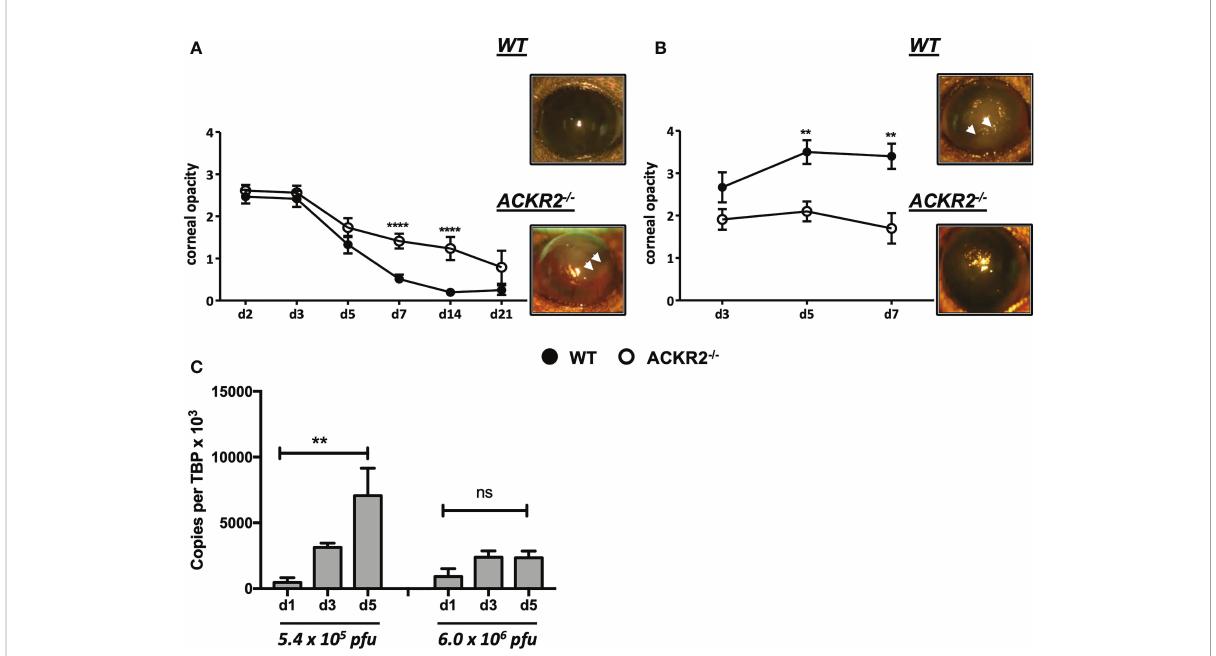
FIGURE 1 Deletion of ACKR2 exacerbates moderately severe HSK but has no effect on severe/maximal HSK. (A, B) Corneas of 6-8 weeks old sex-matched WT ( fi lled circle) and ACKR2 -/- (clear circle) mice were infected with HSV-1 virus after corneal scari fi cation. Severity of clinical disease in infected mice was evaluated by corneal opacity scores. Corneal opacity score and representative clinical images at day 7 p.i. in mice infected with (A) 5.4 x 10 5 pfu, N = 6-43; and (B) 6.0 x 10 6 pfu, N = 10-14. White arrow heads indicated level of hypopyon – see main text for explanation. Statistical signi fi cance was determined using Mann-Whitney U test with ** p <0.01, **** p <0.0001. Data are pooled results from independent set of experiments presented as mean ± SEM. (C) Corneas from 5.4 x 10 5 pfu and 6.0 x 10 6 pfu HSV-1 infected WT mice were harvested at day 1, 3 and 5 p.i. for qPCR analysis of ACKR2 expression. N = 4-6. Statistical signi fi cance was determined using one-way ANOVA with ** p < 0.01. ns: not signi fi cant. Data are presented as mean ±